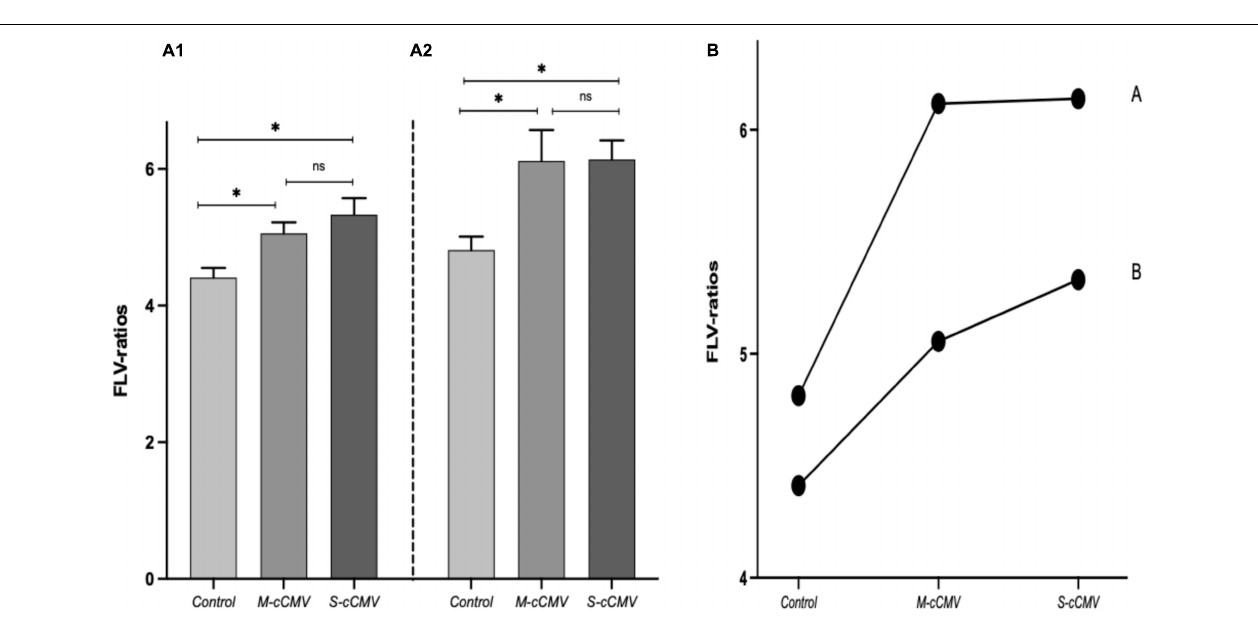
FIGURE 3 | (A) Fetal liver volume (FLV) between study groups, data presented as median (IQR: interquartile range: p25–p75). [ ∗ p -value as determined with the Wilcoxon rank-sum test (Mann-Whitney U); p = 0.22 ]. (B1) FLV/AC-ratio (cm 3 /cm), and (B2) FLV/FBV-ratio between the study groups. Data presented as mean (SD). ∗ p -value as determined with the t -test; p < 0.001 in both. cCMV: congenital cytomegalovirus fetuses ( n = 32). Controls: ( n = 33). AC, abdominal circumference; FBV, fetal body volume.